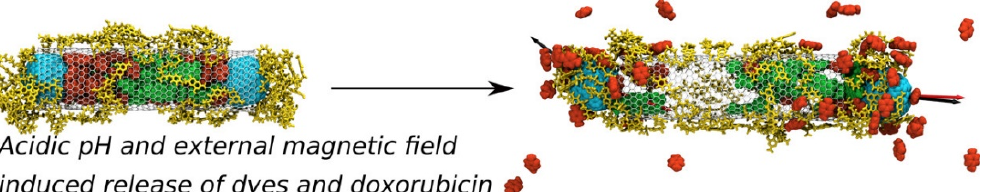
Figure 9. Snapshots of simulations of the carbon nanotubes (CNT) functionalized with PEGylated folic acid (yellow). Doxorubicin (green) and fullerene (light blue) were initially located in the inner cavity of CNT. After 1.5 ns of simulations, doxorubicin molecules are released from CNT at acidic pH but not at neutral pH (reprinted with permission from [217]. Copyright (2018) American Chemical Society).